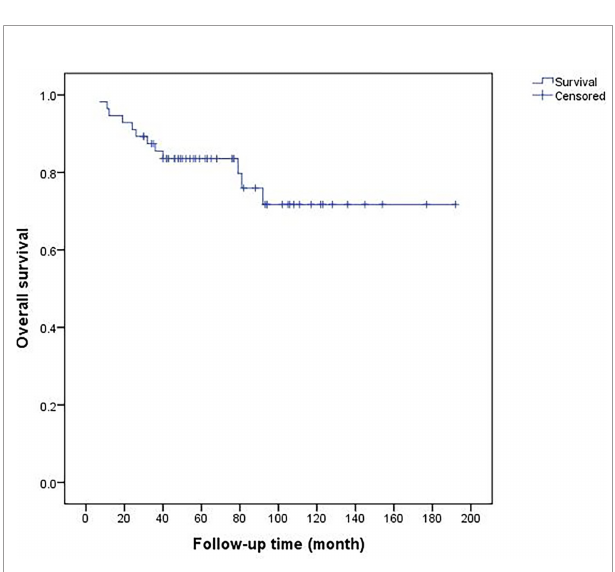
FIGURE 7 | ① The preoperative radiographs of a 51-year-old woman with osteosarcoma of the proximal ulna. ② An unplanned excision and tumor recurrence occurred. ③ The radial head was displaced and inserted into the intercondylar of the humerus after proximal ulna resection; the rotation function of the forearm is shown 76